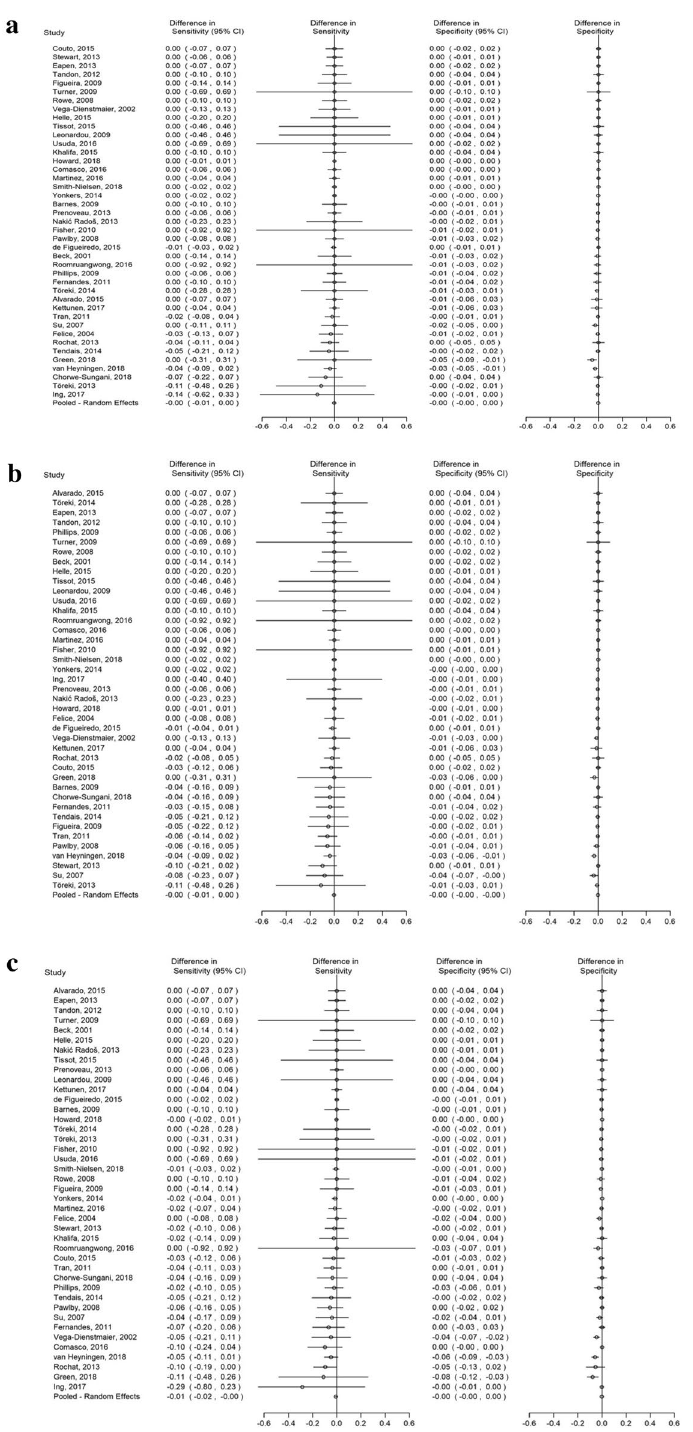
Figure 2. ( a )–( c ) Forest plots of the difference in sensitivity and specificity estimates between EPDS-9 and full EPDS among all studies at cut-offs ( a ) ≥ 10, ( b ) ≥ 11, and ( c ) ≥